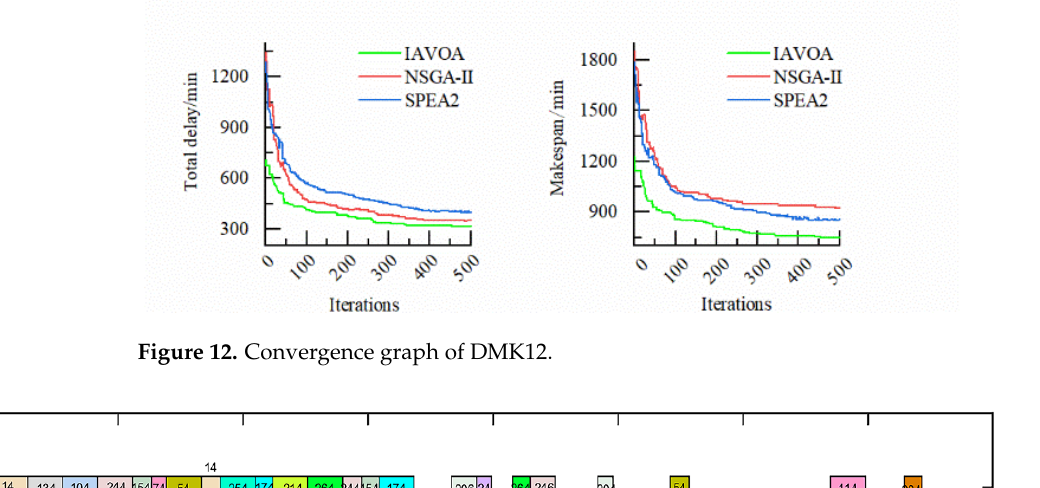
Figure 11. Line chart of the optimization problem values.